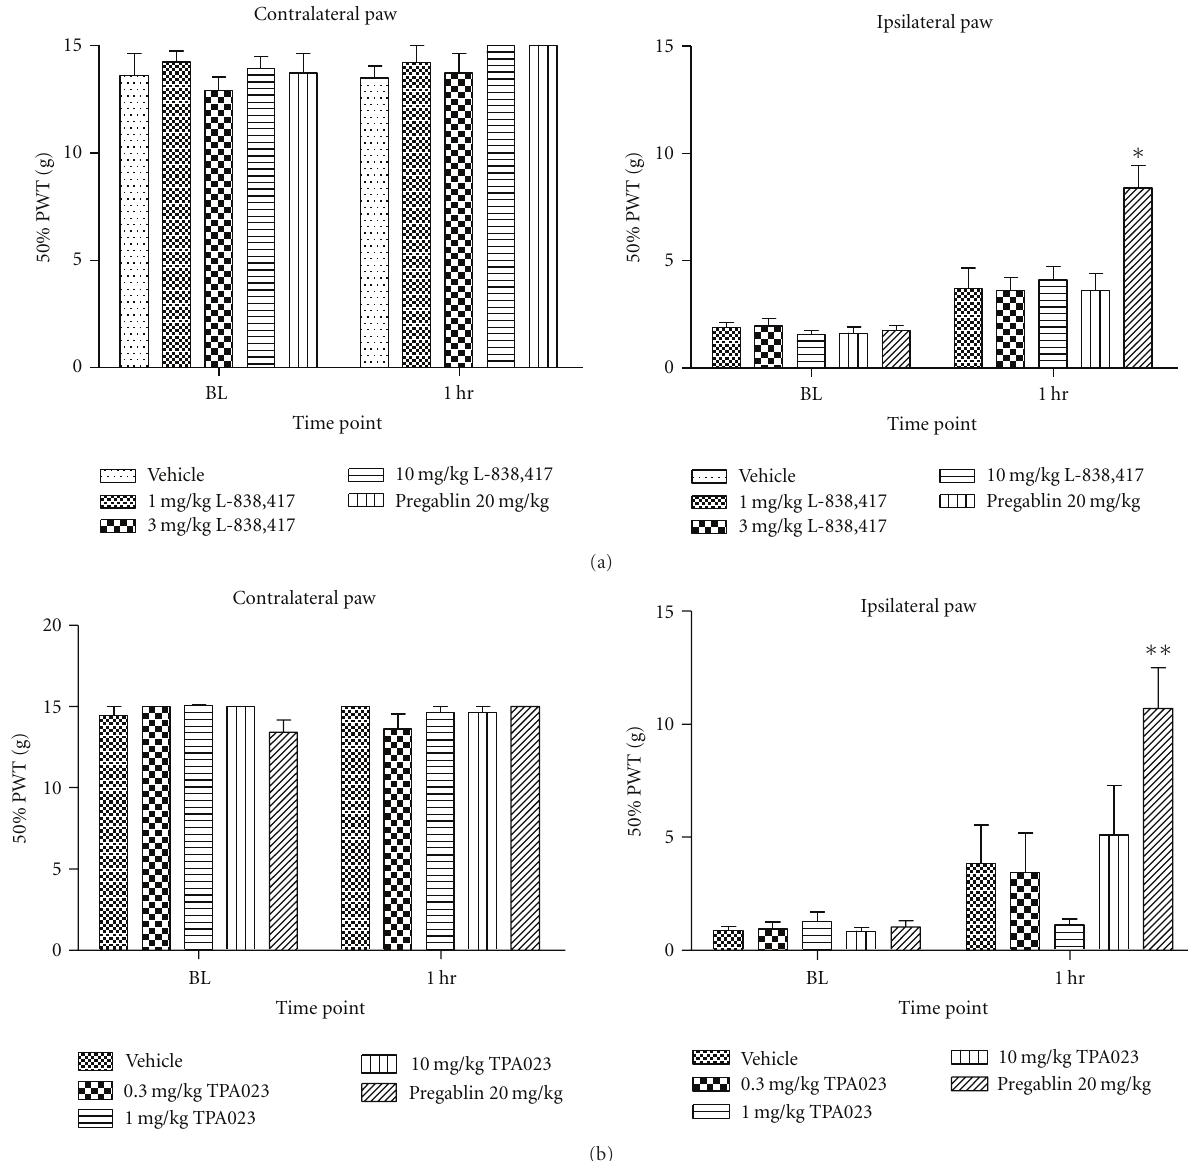
Figure 3: The e ff ects of (a) L-838,417 and (b) TPA023 on tibial nerve transection-induced static allodynia in the rat. Data are means ± sem. n = 22. Data are expressed as 50% paw withdrawal threshold (PWT). BL: baseline. ( ∗∗ = P < 0 . 01, ANOVA compared to vehicle-treated